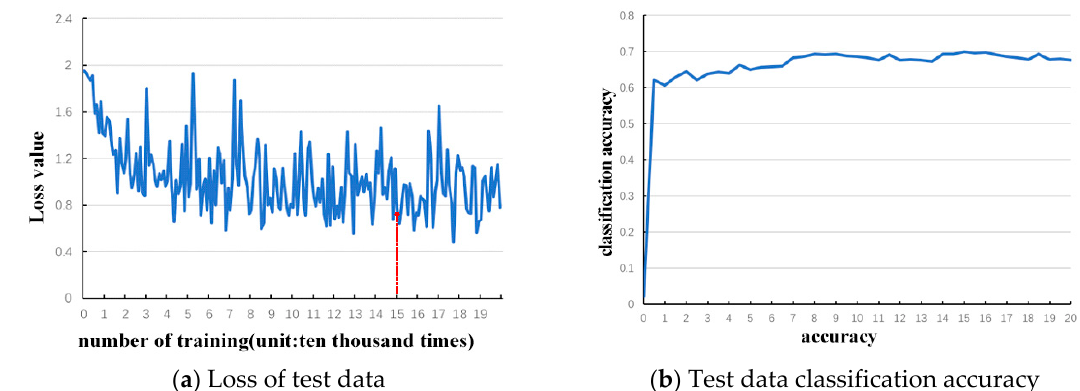
Figure 6. Trends of the CNN loss value and the accuracy of the results with increasing training time. (With increasing training time, the loss first decreases and then tends to be gentle, and the accuracy first increases and then tends to be gentle.)